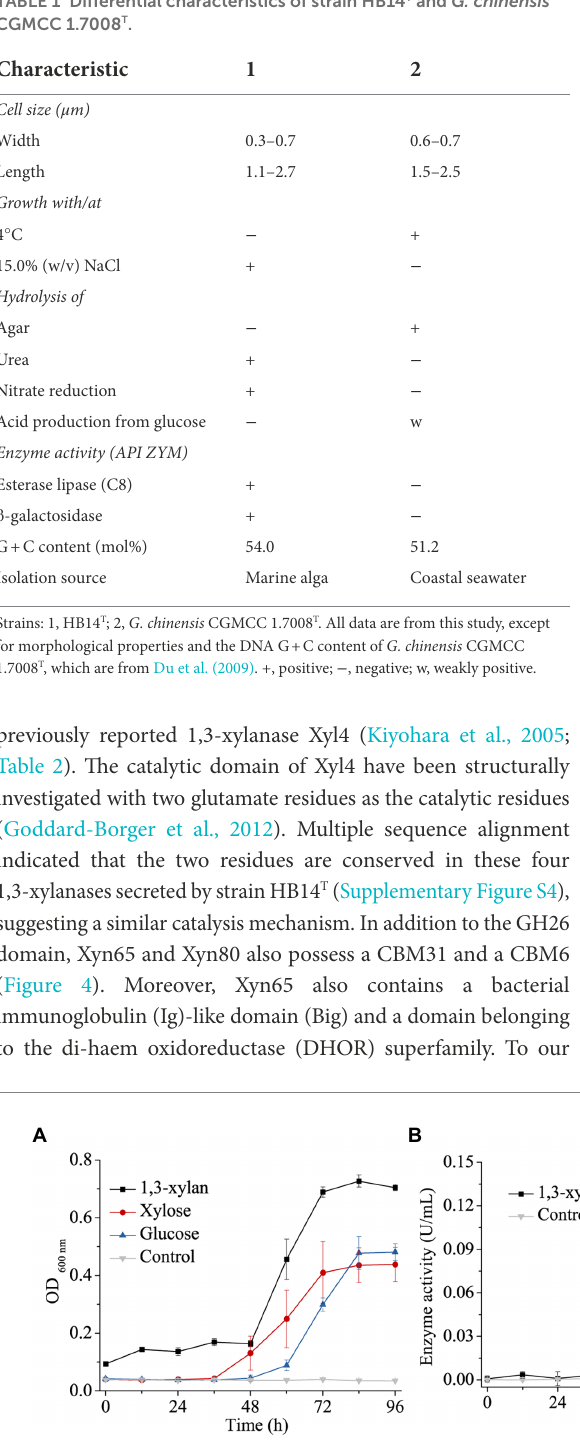
FIGURE 3 Growth of strain HB14 T on 1,3-xylan and the induction of extracellular 1,3-xylanase activity. (A) Growth curves of strain HB14 T on 1,3-xylan, xylose and glucose. Strain HB14 T was cultivated at 30 ° C and pH 7.5 with 0.2% (w/v) 1,3-xylan, xylose or glucose as the sole carbon source. The culture without carbon source was treated as the control. (B) The extracellular 1,3-xylanase activities during the cultivation of strain HB14 T on 1,3-xylan. The 1,3-xylanase activities were determined at 30 ° C in PBS (pH 7.0). The extracellular 1,3-xylanase activity of strain HB14 T cultivated without carbon source was treated as the control. (C) , The extracellular 1,3-xylanase activity of strain HB14 T grown on 1,3-xylan, xylose or glucose at the late-log phase. Cultures of strain HB14 T at 84 h on each substrate of 1,3-xylan, xylose and glucose were collected separately. Then, the extracellular 1,3-xylanase activities of the culture were determined at 30 ° C in PBS (pH 7.0). The data shown in the graph are from triplicate experiments (mean ±